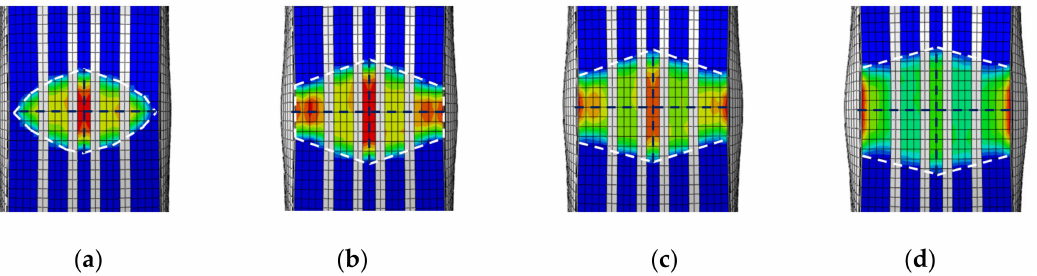
Figure 10. Footprint of passenger car tire: ( a ) δ = 3 mm; ( b ) δ = 10 mm; ( c ) δ = 15 mm; ( d ) δ = 20 mm.